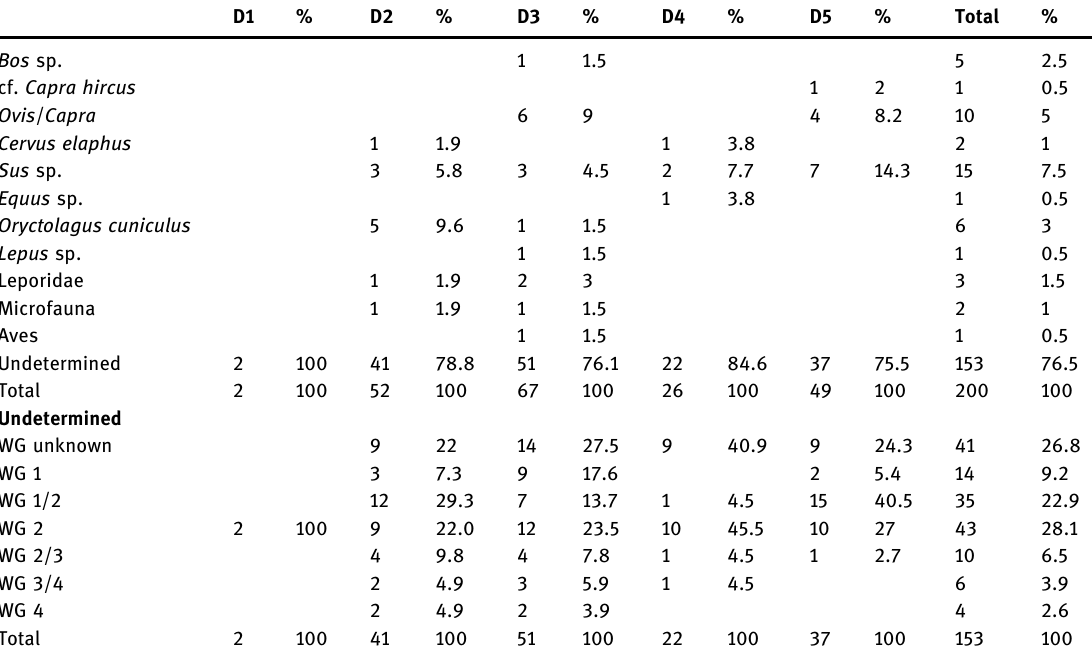
D1 % D2 % D3 % D4 % D5 % Total %